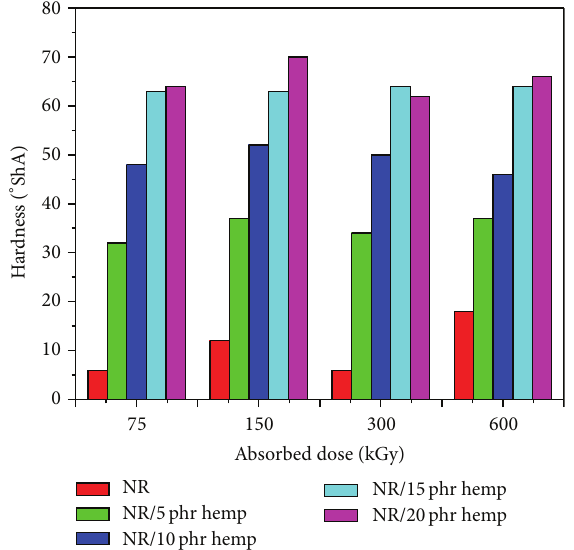
Figure 1: Hardness variation as a function of hemp amount and irradiation dose.